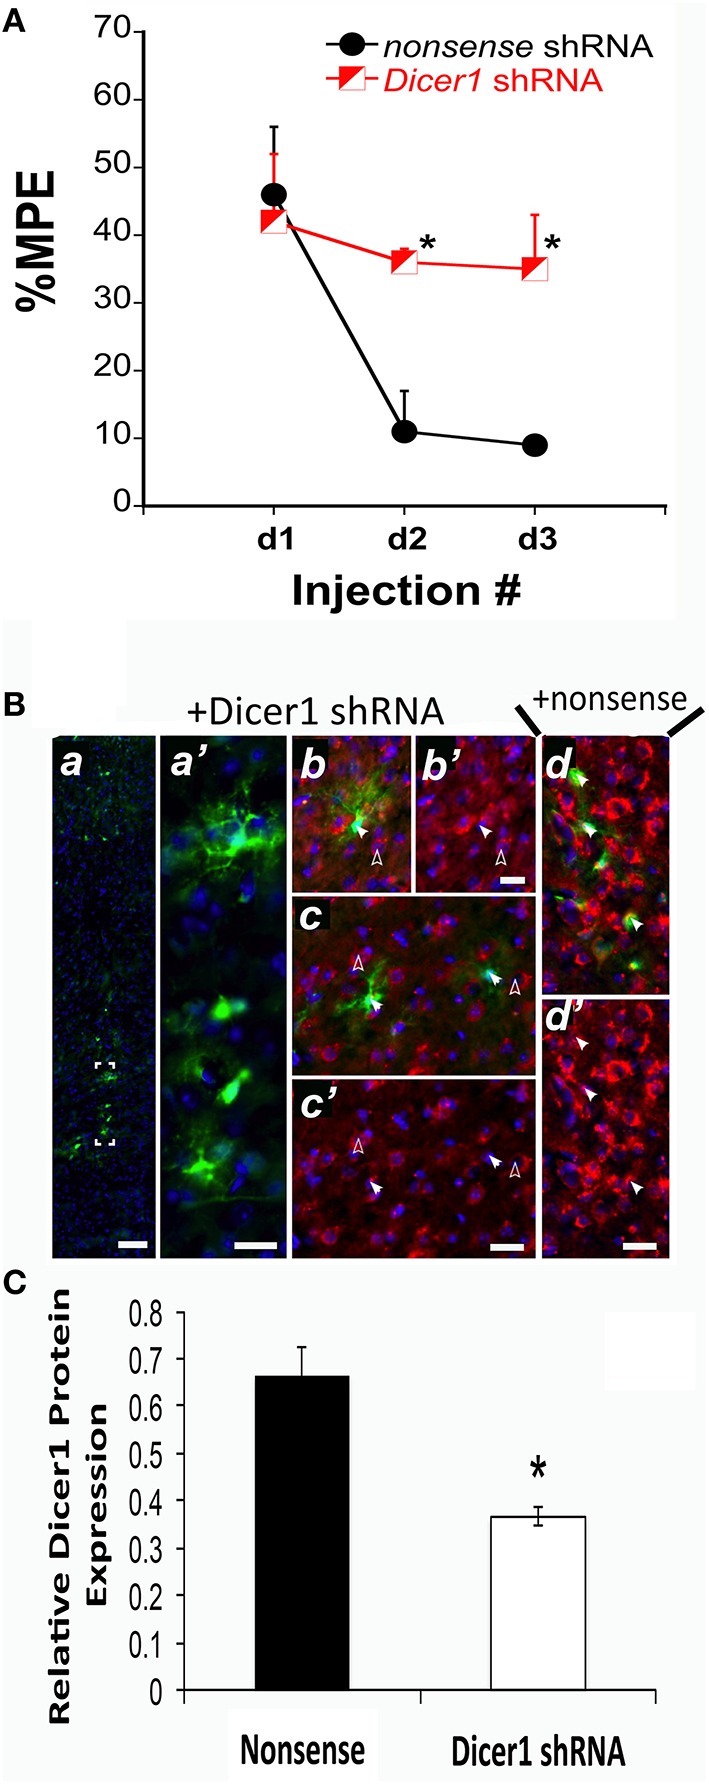
shRNA targeting Dicer1 in B6 mice significantly reduced the development of tolerance. (A) The %MPE following 31.2 mg/kg morphine (s.c.) across three injections each spaced 48 h apart significantly decreased in nonsense control mice and not in Dicer1 shRNA treated mice. *Significantly different than nonsense control (P < 0.030, 0.001); (n = 6,5 for Dicer1 shRNA and nonsense controls, respectively). (B), Immunohistochemistry was performed on behaviorally phenotyped animals in (A). GFP-positive PFC cells indicate successful transduction with lentivirus carrying Dicer shRNA. GFP-staining was observed along the injection track in the PFC (a). Bracketed region in A shown enlarged (a′). To examine the efficacy of the shRNA-mediated Dicer1 knockdown in GFP-positive PFC cells, Dicer protein was co-stained by immunofluorescence with a Dicer1-specific antibody (red). Nuclear DNA was co-stained with DAPI (blue channel). In GFP-positive PFC cells containing Dicer1 shRNA (solid arrows in b,c), perinuclear Dicer1 expression is significantly reduced (solid arrows in b′,c′). By comparison, untransduced neighboring cells not expressing GFP (open arrows in b,c) have high expression of Dicer1 (open arrows in b′,c′). In cells transduced with lentivirus delivering nonsense shRNA control, GFP-positive cells (closed arrows in d) retained strong perinuclear Dicer1 protein expression (closed arrows in d′). Immunofluorescent images are representative from six animals transduced with lentivirus carrying Dicer1 shRNA and chronically treated with morphine, and five animals transduced with lentivirus carrying nonsense shRNA control and chronically treated with morphine. Scale bars (inset white lines) in (a) = 100 μm and (b–d) = 25 μm. (C) Quantification of Dicer1 immunofluorescence in the PFC (B). Bar graph represents relative Dicer1 protein levels in GFP-expressing cells from control (nonsense shRNA) and Dicer1 shRNA-treated animals. A total of 31 and 40 well-demarcated GFP-expressing cells from control and Dicer1 knockdown animals, respectively were quantified as described in Materials and Methods Section. *Significantly different from nonsense shRNA-treated animals (P < 0.0001).